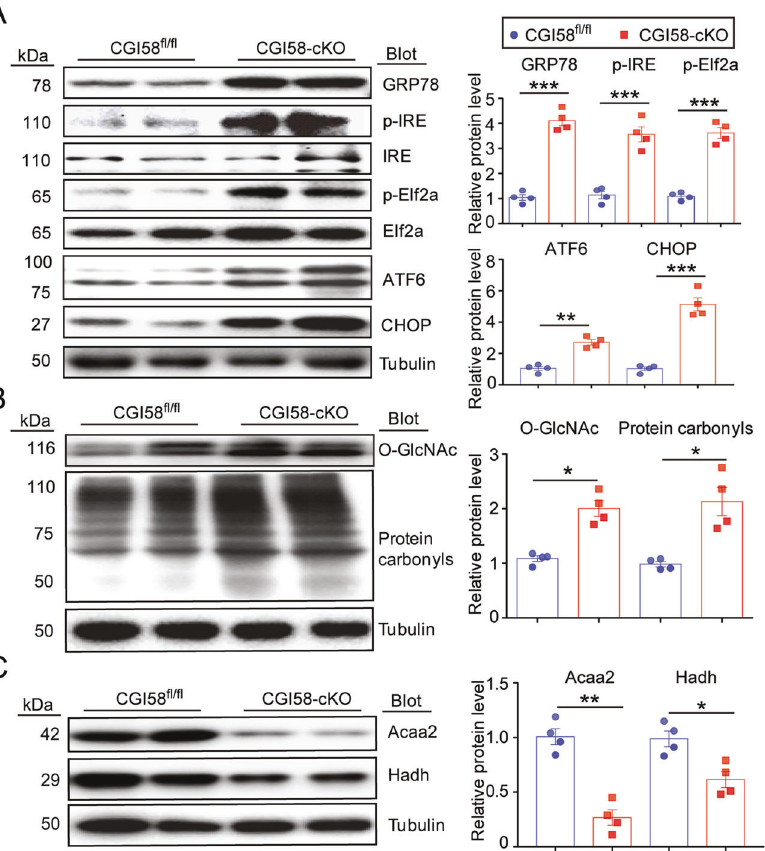
Fig. 5 CGI-58 knockout in fl uences ER stress, oxidative stress, protein glycosylation, and fatty acid oxidation in the heart. A – C CGI-58 fl / fl and CGI-58 cko mice were fed with ND for 3 months, and then the protein levels of GRP78, p-IRE, p-Elf2a, ATF6, CHOP, O-GlcNAc, protein carbonyls, Acaa2, and Hadh in the heart were examined. All statistical results are shown right, n = 4 per group. Data are presented as mean ± SEM, and n represents the number of samples or animals. * P < 0.05, ** P < 0.01, *** P <